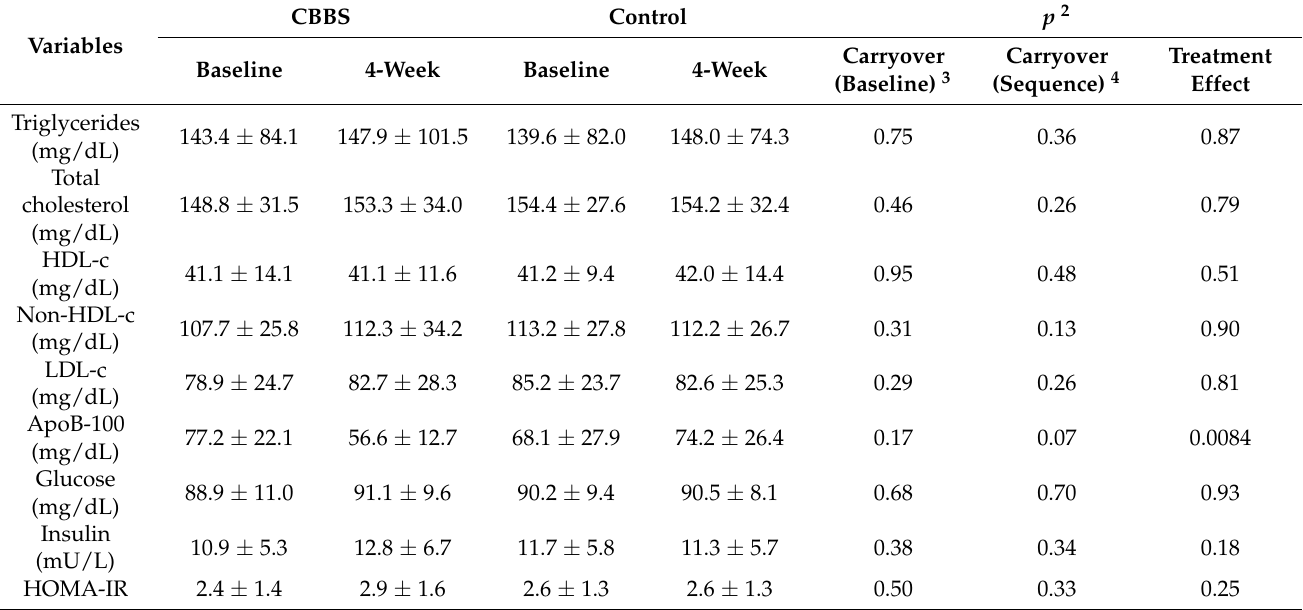
Table 4. Biochemical parameters of 4-week follow-up data of the CBBS group and the control group 1 .